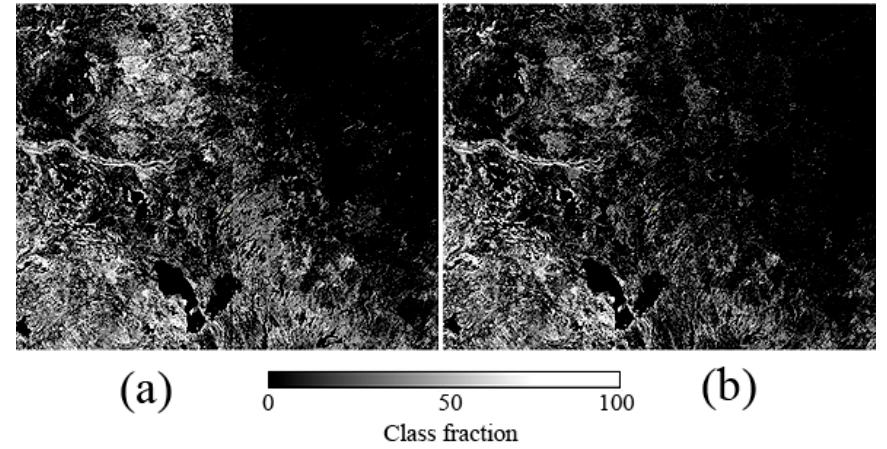
Figure 8. The effect of the window-based local optimization on the mixed forest class across tile boundary 4-2 to 4-3, before ( a ) and after ( b ).